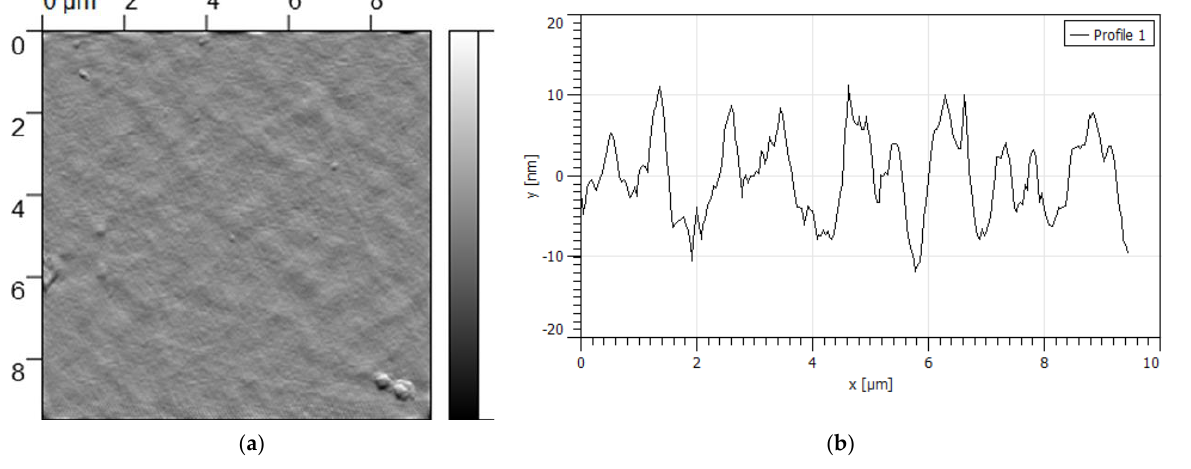
Figure 4. Atomic force microscopy (AFM) image of drug-free multilayer film MLF-PL ( a ), and cross-section ( b ).